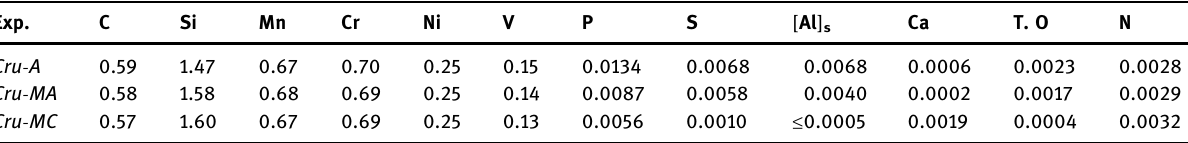
Table 4: The mass percentage of each element in the experimental steel ( wt% )